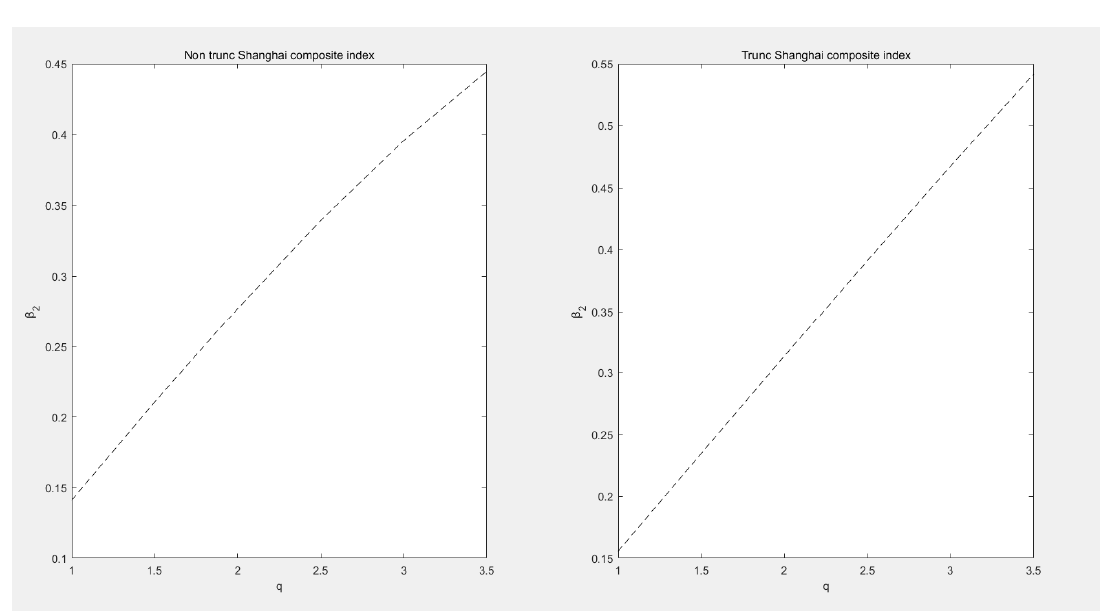
Figure 3. β against q based on logarithm forms of both non-truncated spot volatility and Figure 3. β 2 against q based on logarithm forms of both non-truncated spot volatility and truncated (cid:2870) truncated spot volatility for the Shanghai Composite Index (SSE Index). spot volatility for the Shanghai Composite Index (SSE